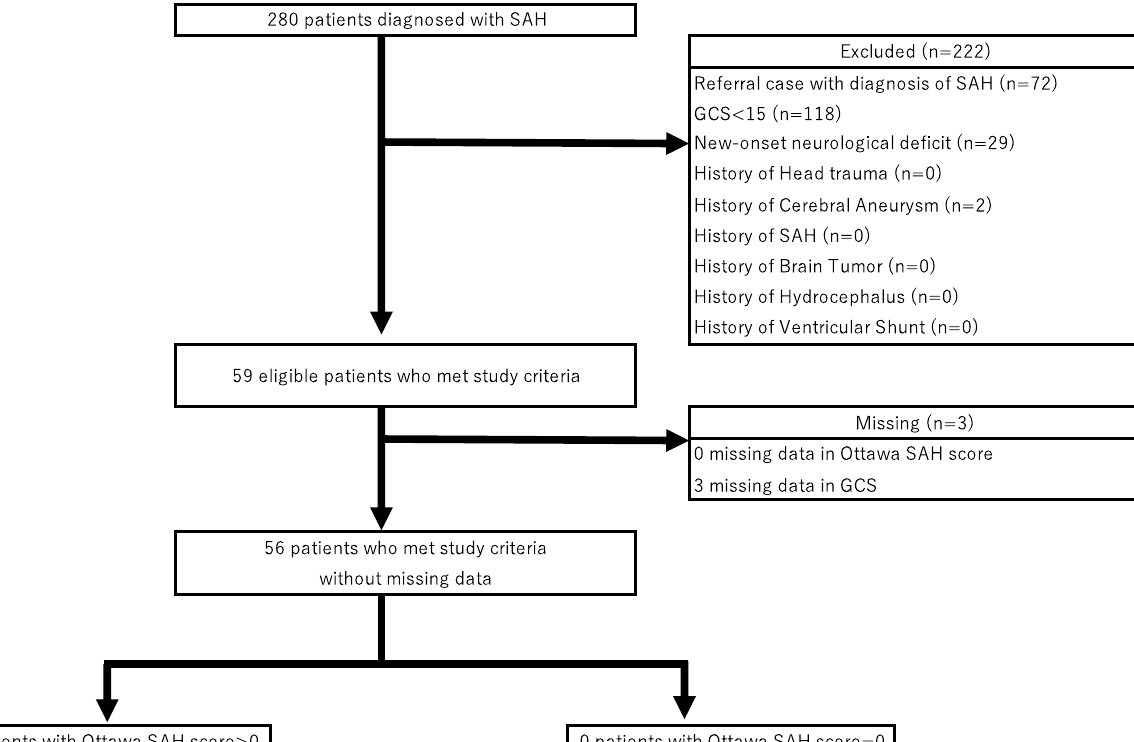
Figure 1. Flow diagram for the validation study of the Ottawa subarachnoid hemorrhage rule. GCS=Glasgow Coma Scale, SAH=subarachnoid